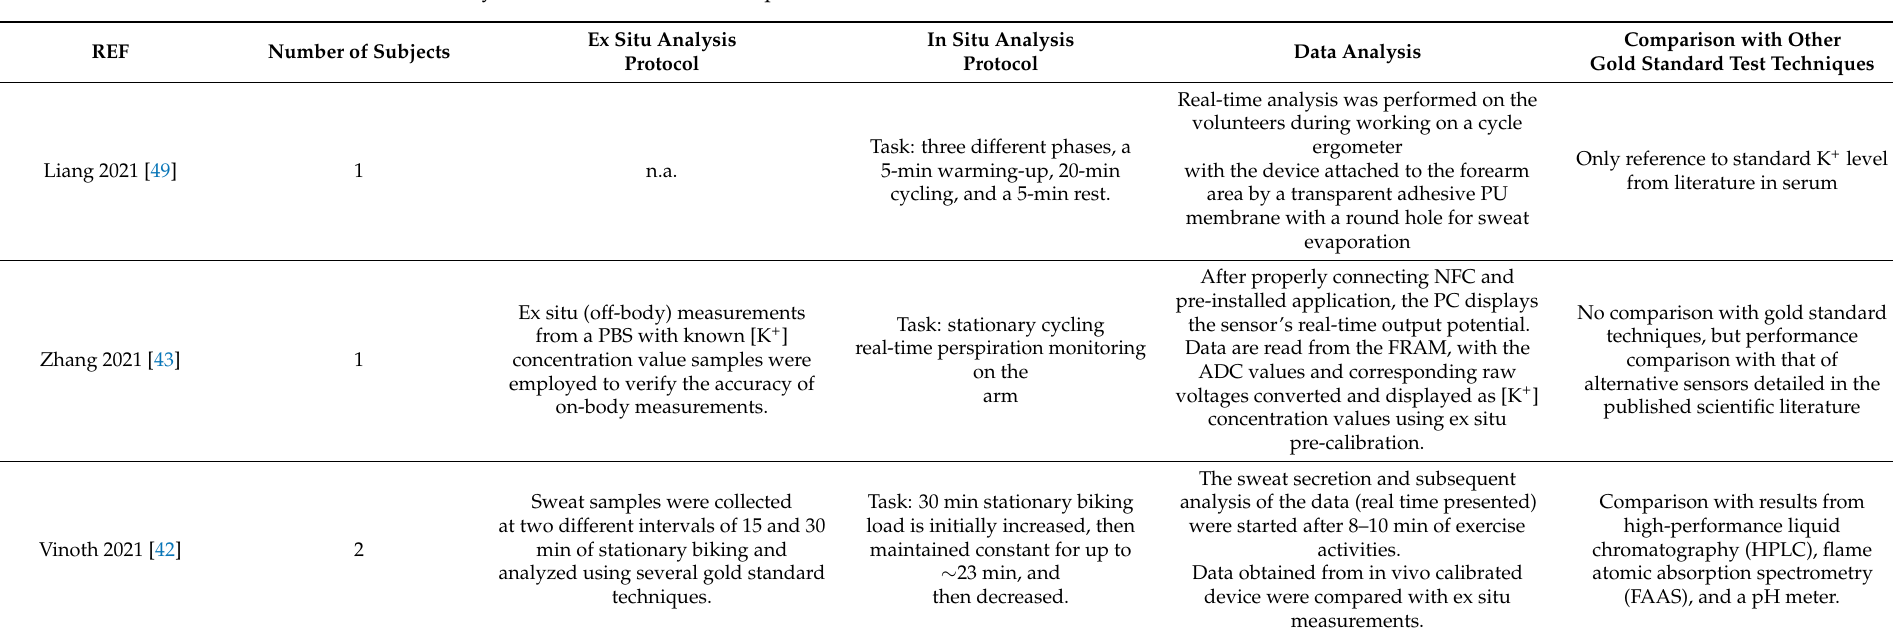
Table 4. Summary of in vivo characterization